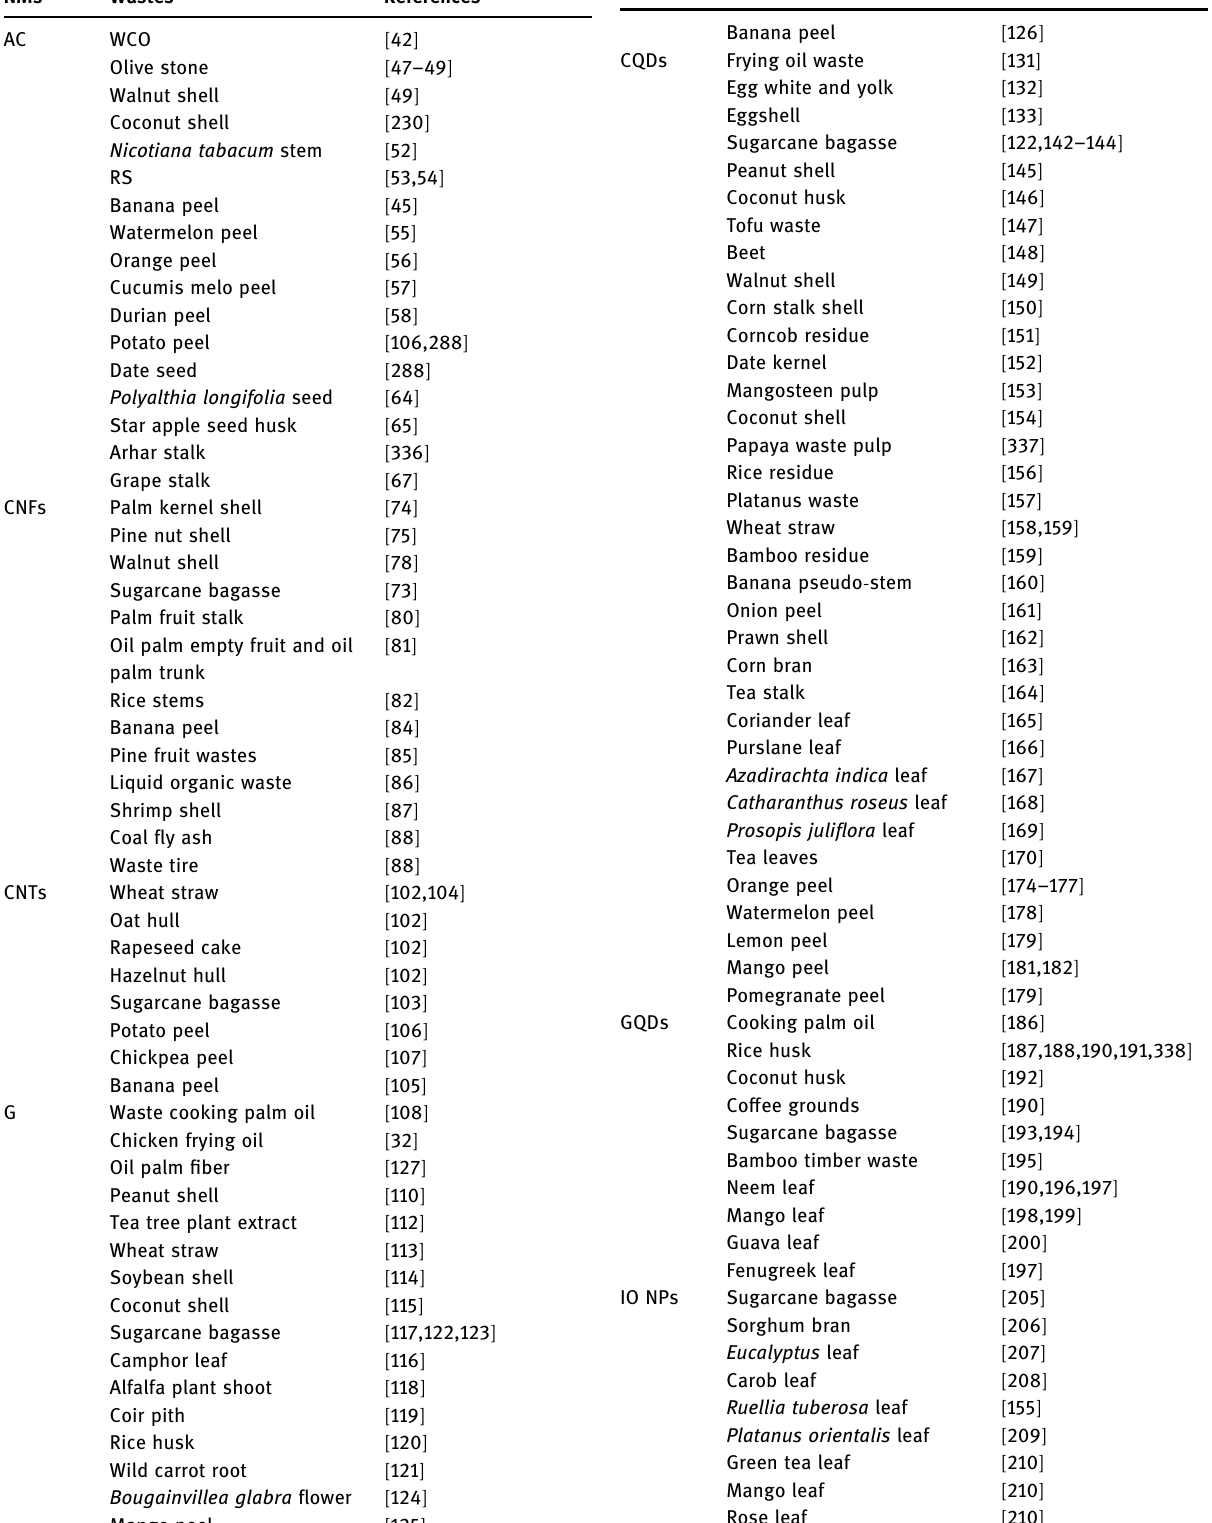
Table 1: Di ff erent types of recycled wastes used for the